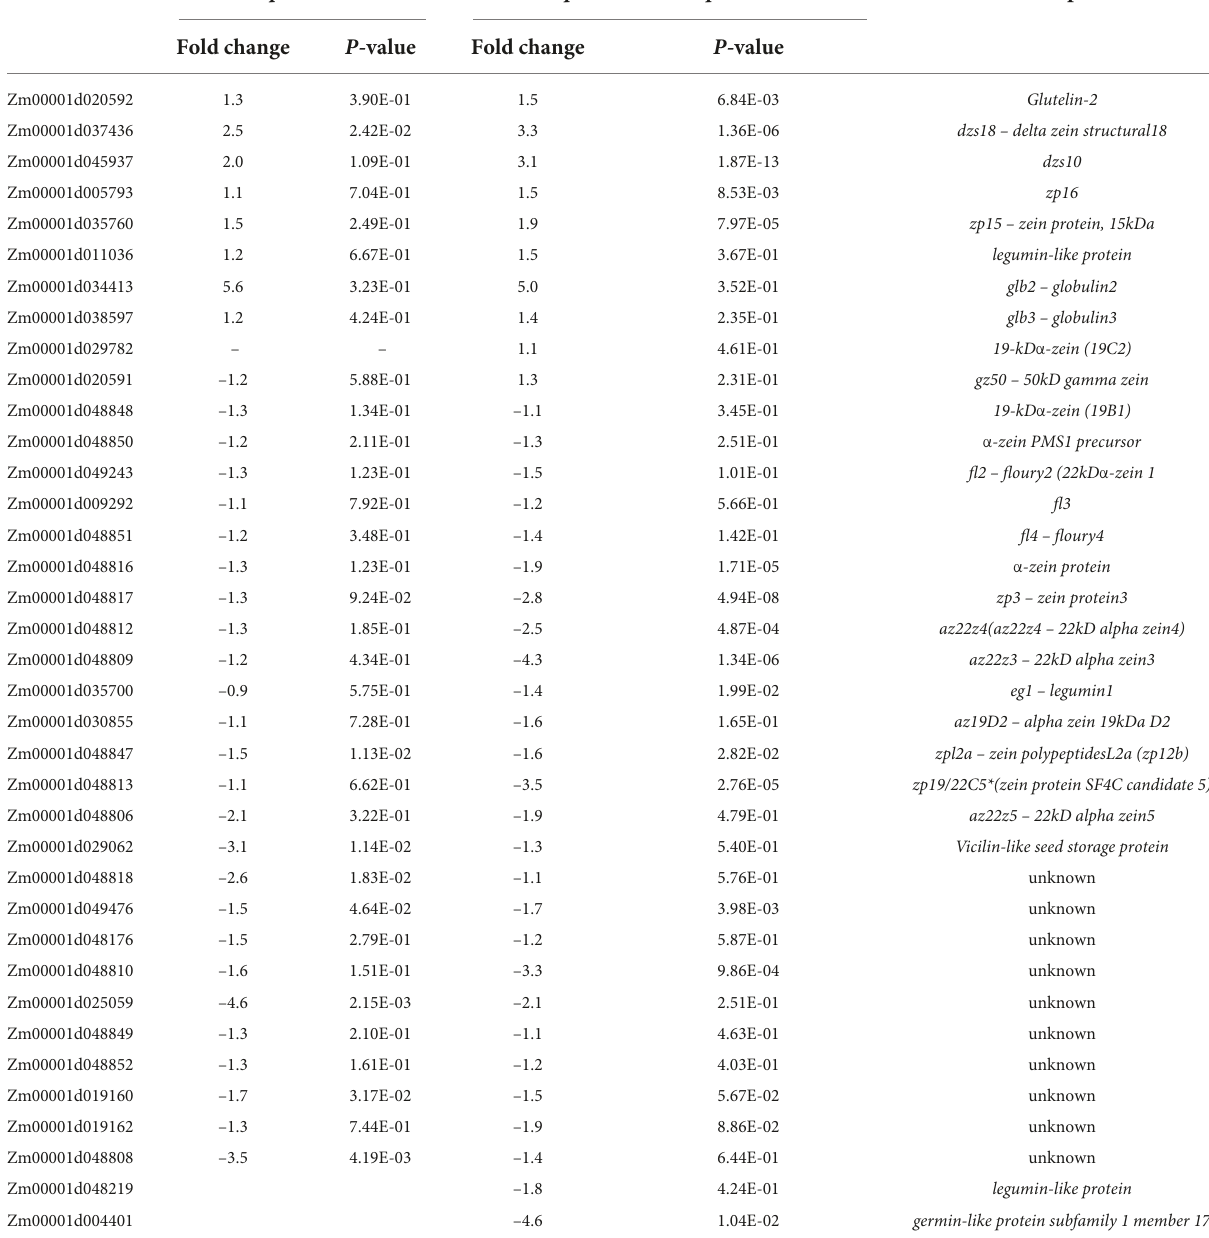
TABLE 2 List of nutrient reservoirs activity related